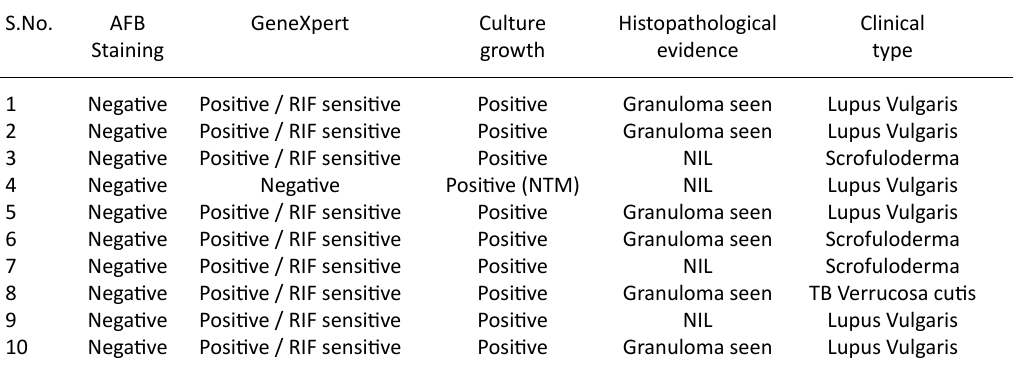
Table 4. Clinical variants and Laboratory data of samples S.No.